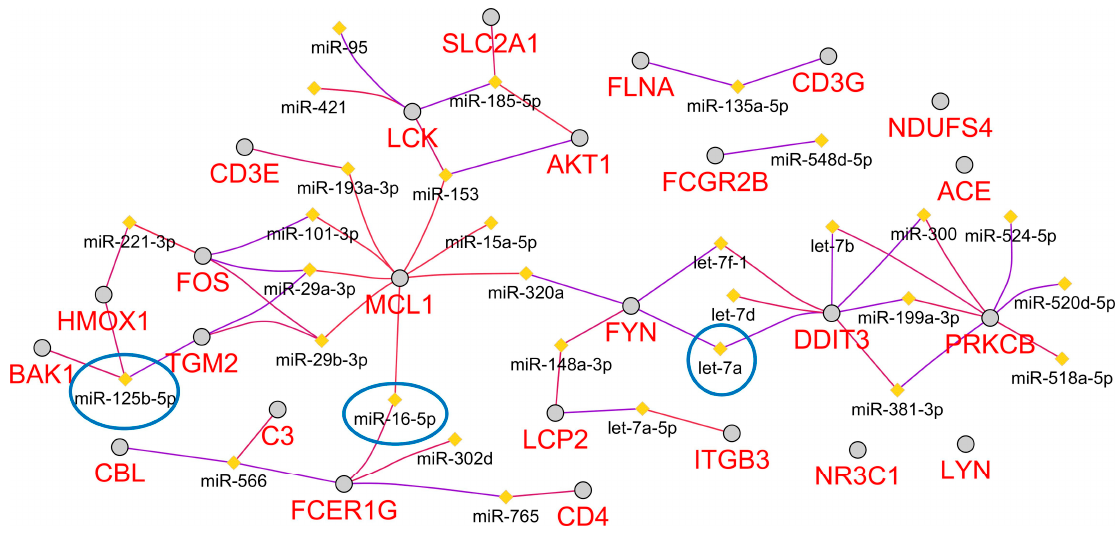
Figure 6. The top 30 miRNAs associated with all the key genes determined by Cytoscape [70] plugin referred to as ClueGo [71].